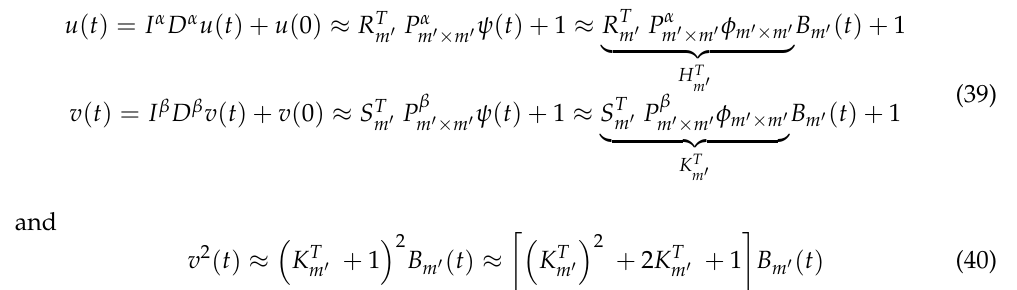
Table 2. Absolute errors u E and v E corresponding to of Example 2.